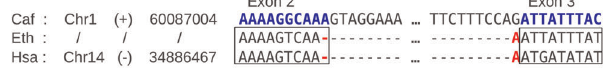
in the LCA of Catarrhini . The pseudogenes in Gorilla , Pongo , Pan and Homo do not have introns and surely represent retroposon fixed at least since the LCA of Catarrhini . It is interesting to note that the original orthologs to Mus Sult3a1 gene (ortholog from position) have been lost in these species, keeping only the retroposon which has become the unitary pseudogene in primates.